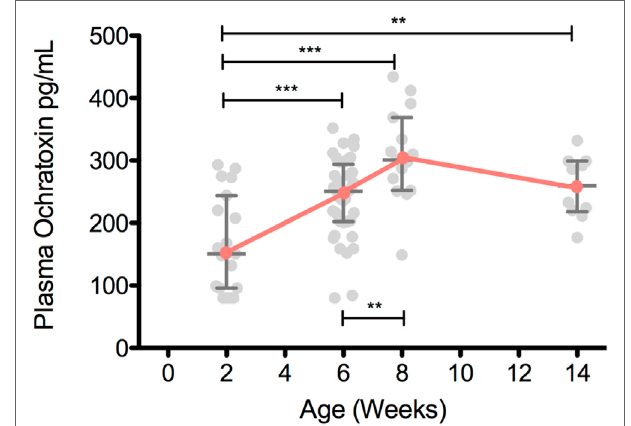
FigUre 1 | Plasma ochratoxin A (OTA) levels are elevated in non-breastfed, South African infants. 2-week-old breastfed ( n = 9) and non-breastfed ( n = 19) infants were comparable in their levels of plasma OTA ( p = 0.1, Student’s t -test). In contrast, at 6 weeks of age non-breastfed ( n = 42) infants showed higher levels of OTA (increased nearly two fold) compared to their breastfed counterparts ( n = 14; p < 0.0001). Bars reflect the median OTA plasma level for each population. The lower limit of detection for the OTA ELISA assay was 80 pg/mL. All infants were